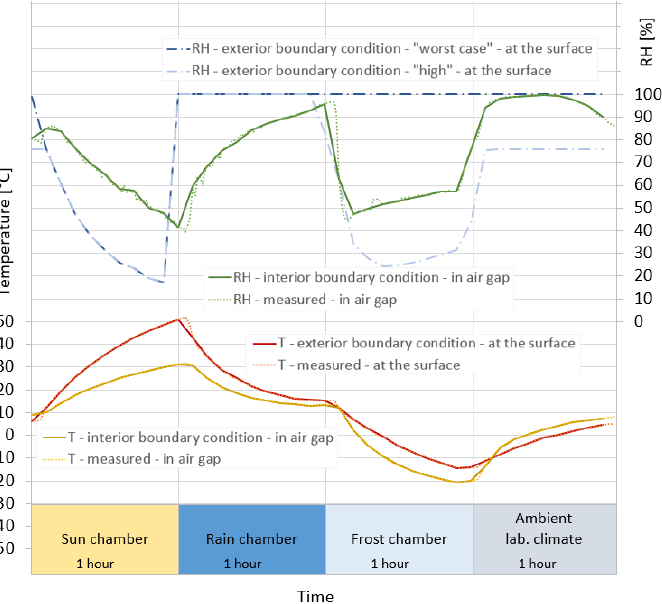
Figure 3. Interior boundary conditions used in the current test setup and exterior boundary conditions used in both the current and the modified test setup. The 4-h period (6-min intervals) corresponds to one rotation in the climate simulator and was repeated for 12 months in the simulations.